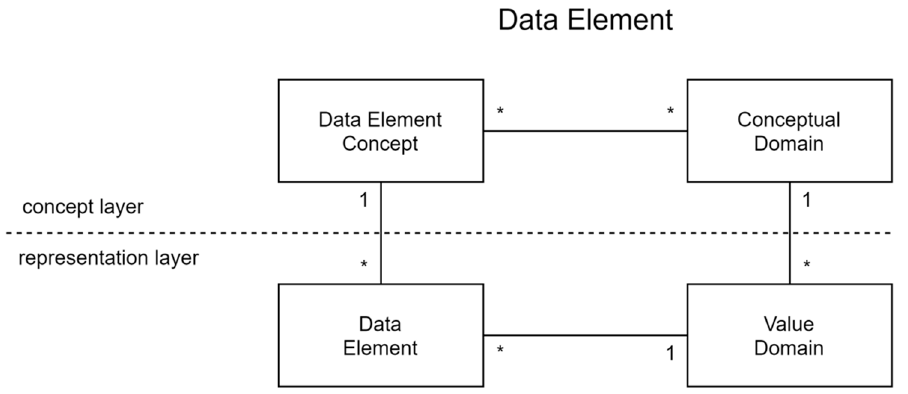
Figure 1. ISO/IEC 11179 Metadata Registry—Data Element.